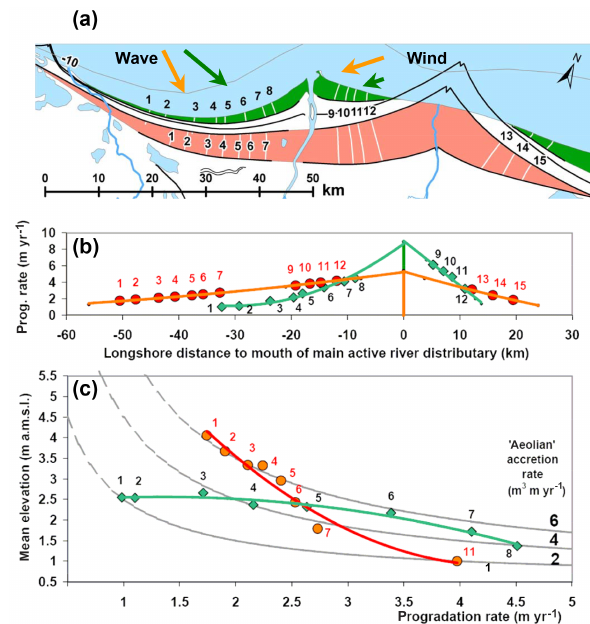
Figure 11. Variability in shore-parallel beach-plain progradation rate (b) and mean elevation (c) for Phase 2 (1800BCE–150CE; or- ange and red) and Phase 3C (1460–1965CE; green). Dashed lines represent calculated elevation values for constant aeolian accretion rates. Arrows in panel (a) indicate the estimated dominant direction of swell driving the formation of the swash deposits and the dom- inant wind direction related to aeolian sand transport responsible for the formation of an aeolian cap on top of the swash-built beach